Question: Describe this figure in one sentence.
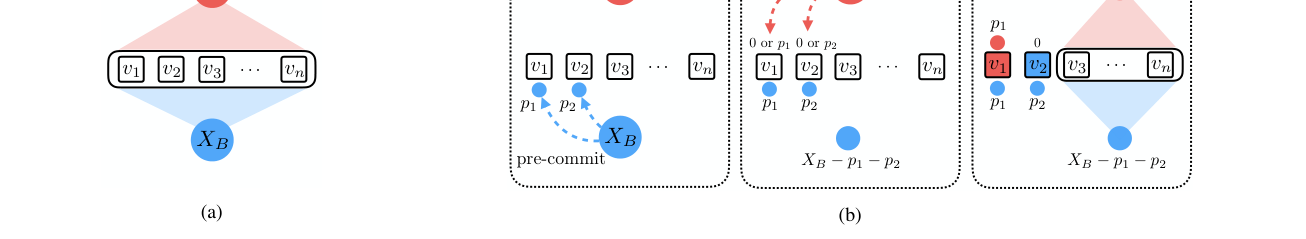
Answer: Model of public pre-commitments. (a) For simplicity, we depict General Lotto games where battleﬁeld valuations are symmetric across players in these diagrams, i.e. GL(XA, XB, v). This is the nominal interaction if no player has the option to pre-commit resources, or the pre-committing player chooses not to pre-commit any resources. (b) Diagrams showing the sequence of events when player B has the option to pre-commit. In step 1, B pre-commits p1 and p2 resources to battleﬁelds 1 and 2, respectively. In step 2, A publicly responds to the pre-commitments by either matching or withdrawing. It secures the battleﬁelds it matches, and loses the ones it withdraws from. In step 3, the players engage in a GL game on the remaining set of battleﬁelds with their remaining resources.